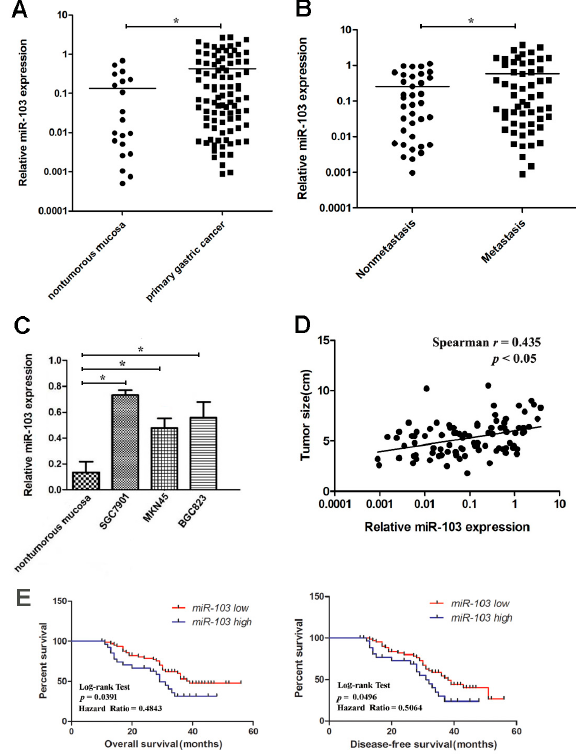
Figure 1. miR-103 is overexpressed in gastric cancer primary tumor tissues and cell lines and correlates with patient survival. ( A ) The miR-103 expression in 92 cases of primary GC tissues compared with 20 cases of adjacent nontumorous tissues analyzed by RT-qPCR; ( B ) The miR-103 expression in primary GC tissues with lymph node metastasis compared with those without lymph node metastasis; ( C ) miR-103 expression in gastric cancer cell lines; ( D ) miR-103 expression was positively associated with tumor size by Spearman’s correlation test ( n = 92) and ( E ) The correlation between miR-103 expression and GC patient survival. * p < 0.05; the data represent the mean ± standard deviation (SD) from triplicate measurements.